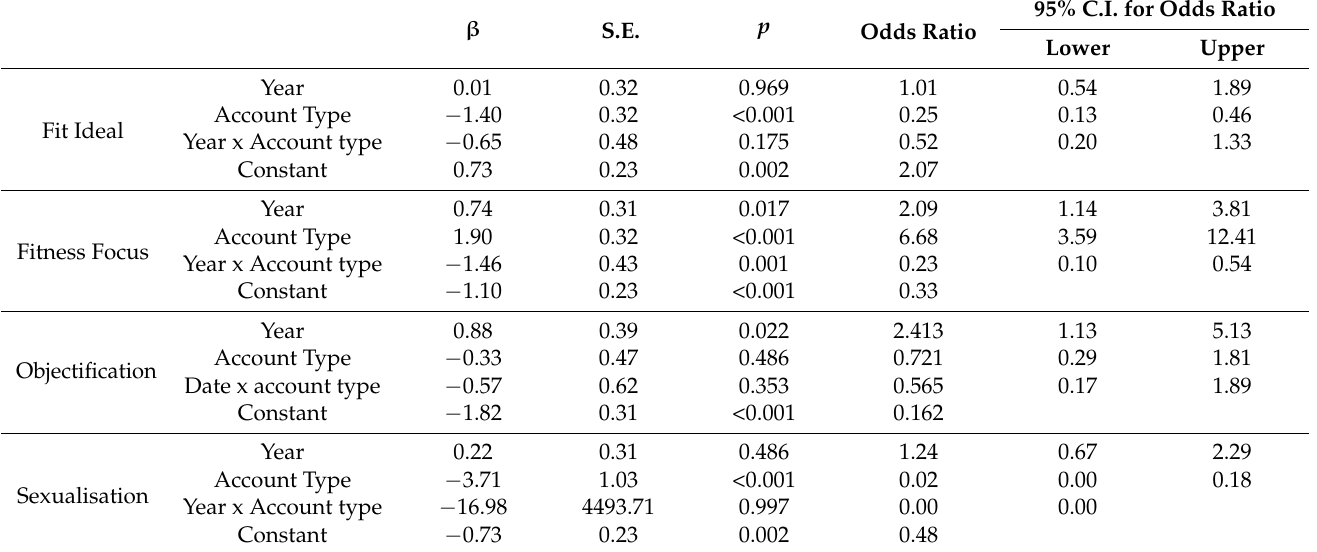
Table 2. Logistic Regression Predicting Likelihood of Outcome Variables.